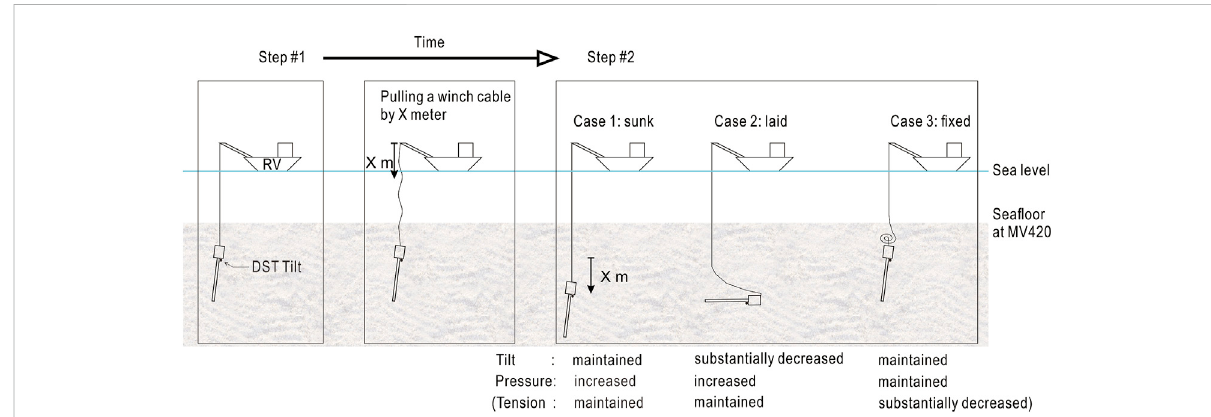
FIGURE 5 Schematic diagram of the experiment during overpenetration of the heat probe. A cable from the winch was released by controlled amount after Step #1, then the heat probe responded to the cable increment at Step #2. Response can be categorized into three situations: sunk, laid, and fi xed. Depending on the situation, the sensor readings are different. Cable tension is not recorded by seconds due to a malfunction of the winch but in